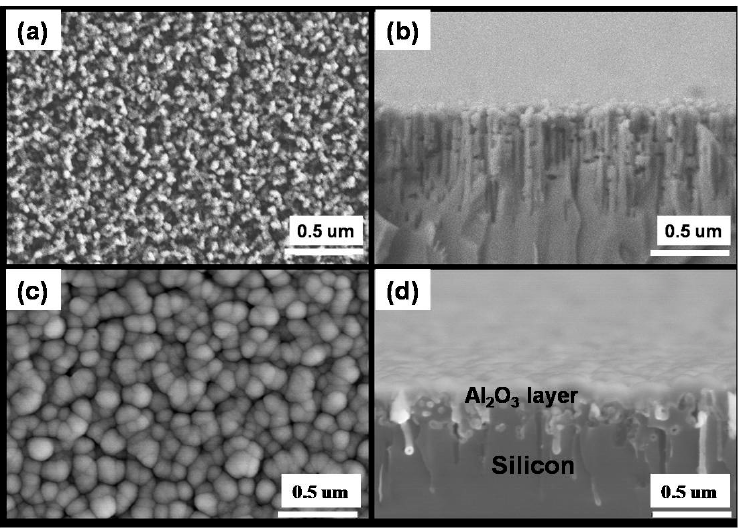
Figure 2. SEM images of silicon nanostructures with passivation layers of ( a , b ) 80 nm SiN X and ( c , d ) 100 nm Al 2 O 3 . The Al 2 O 3 layer filled the gaps in the silicon nanostructures through